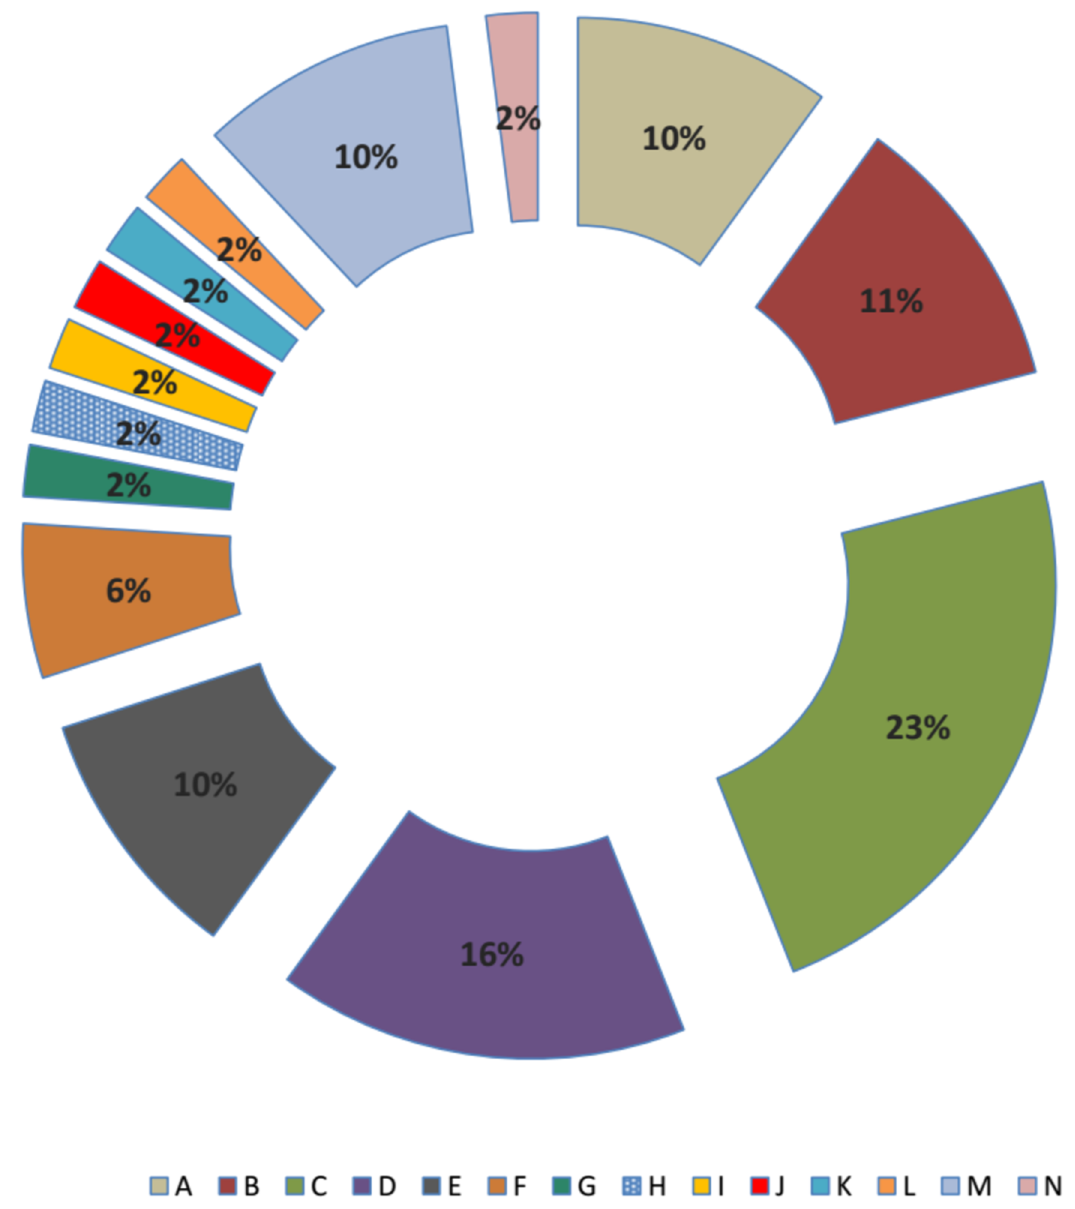
Fig 3. fliC -RFLP of dfrA5 containing isolates (N =